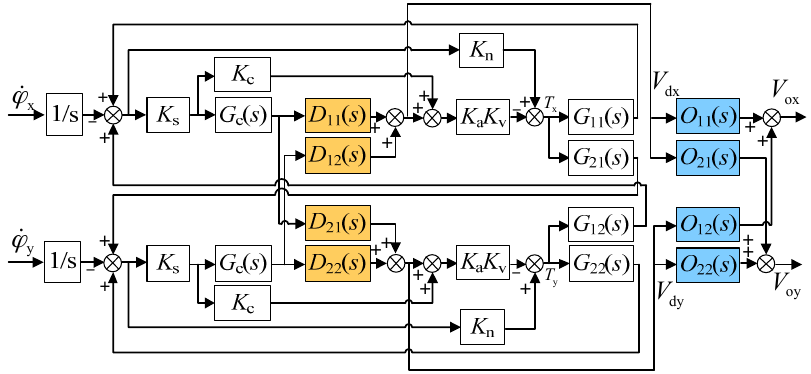
Figure 3. Block diagram of the rebalance loop with full decoupling compensation. Benefitting from the inner-loop and outer-loop compensators, the output voltages of the two sensing axes separate ideally from each other, which is derived as in Equation (10).